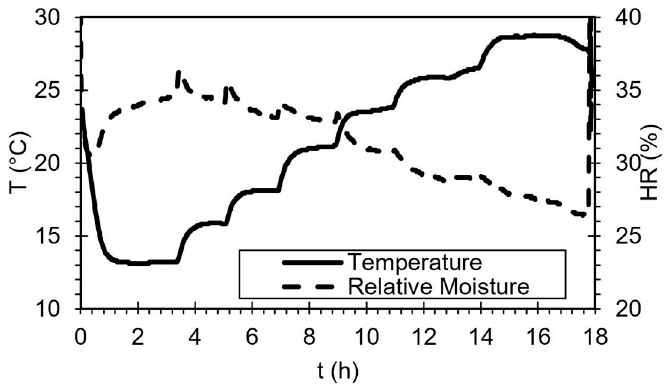
Figure 10. Temperature and relative humidity vessel behavior as a function of time during wood sample test in the tangential direction.